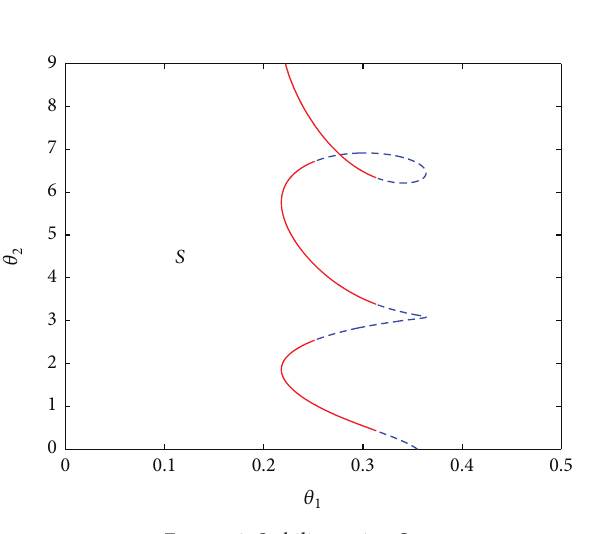
Figure 7: Direction of crossing.